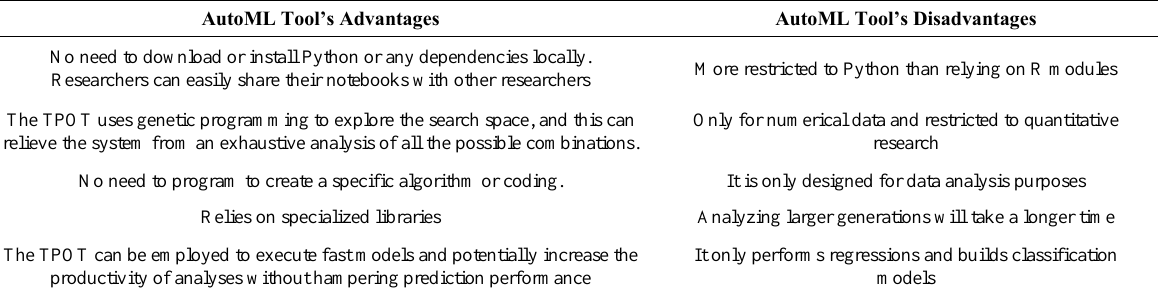
Table 3. Key advantages and disadvantages of